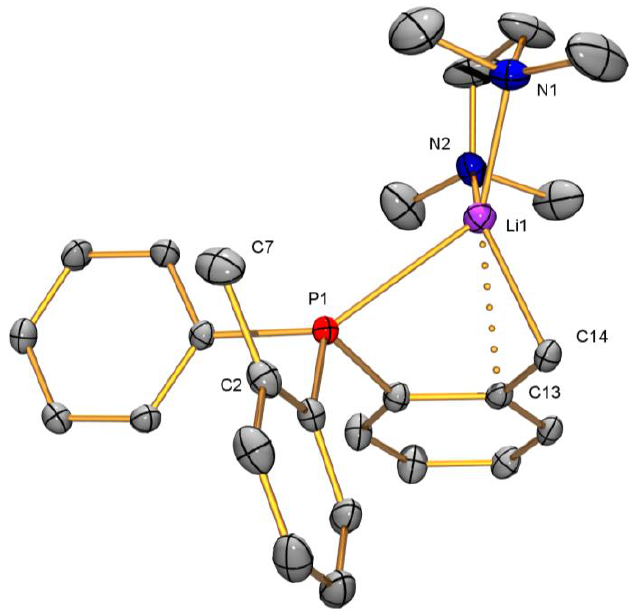
Figure 2. Molecular structure of 2-Li showing thermal ellipsoids at the 50% probability level (all the hydrogen atoms were omitted for clarity). Selected bond lengths (Å) and angles ( ◦ ): P1-Li1 2.680(6), N1-Li1 2.086(6), N2-Li1 2.069(7), C14-Li1 2.219(7), C13-Li1 2.536(7), C14-C13 1.409(5), C2-C7 1.523(5), N2-Li1-N1 87.9(2), C14-Li1-P1 75.75(19), N1-Li1-C14 128.3(3), N2-Li1-C14 127.8(3).